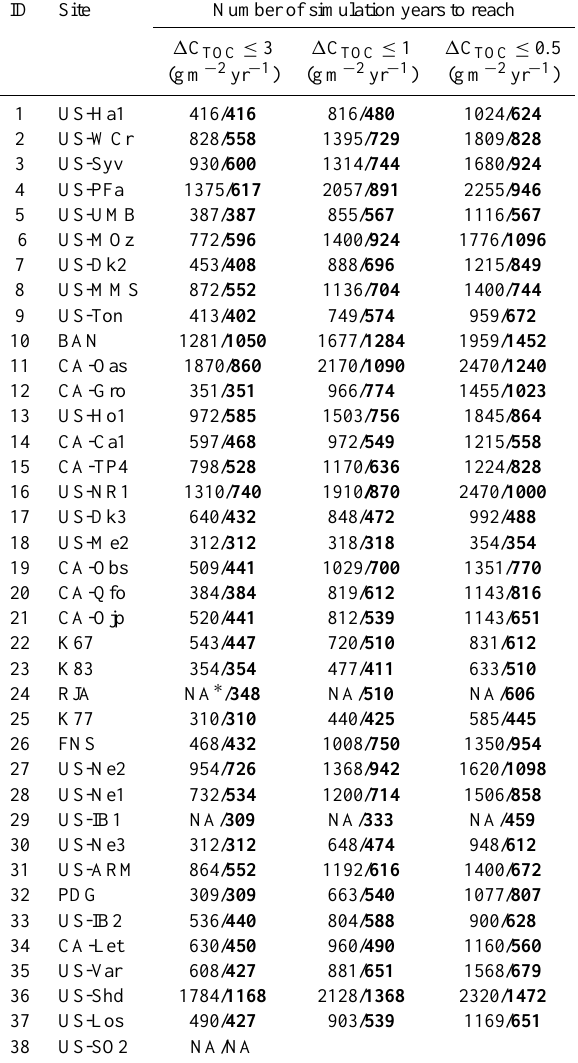
Table 2. Comparison between the gradient projection method (in bold) and the accelerated spin-up method.